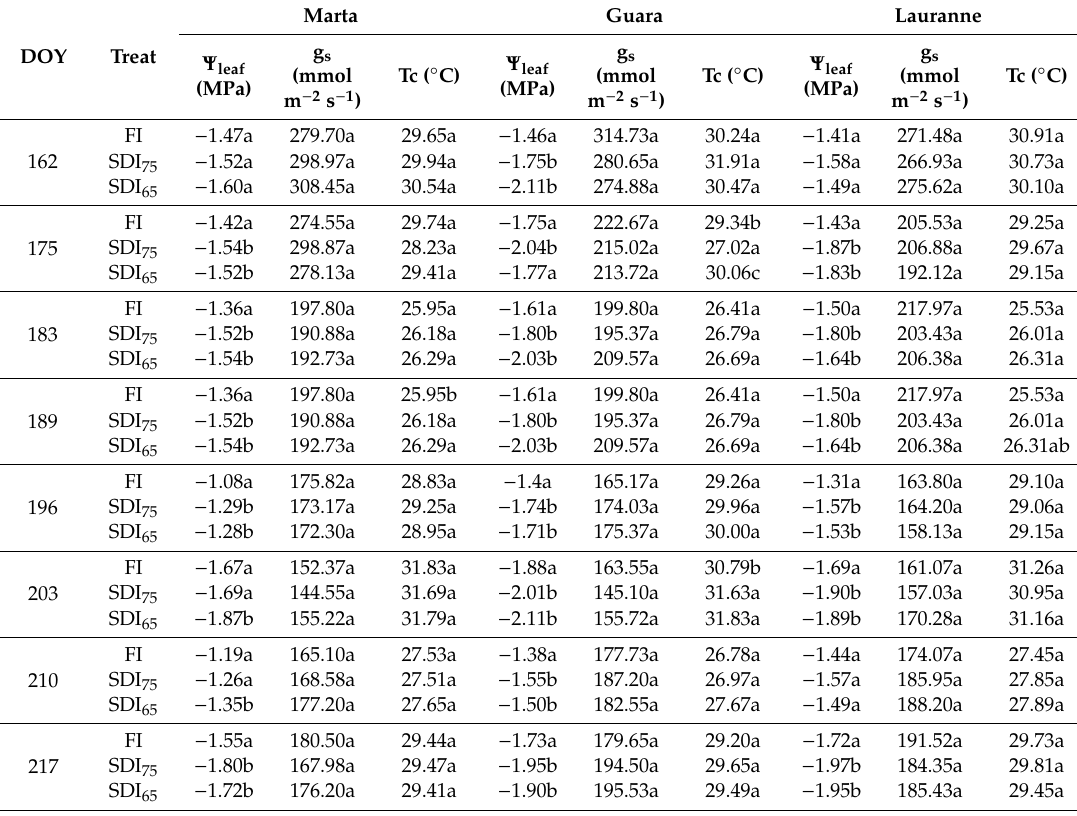
Table 4. Temporal evolution of the physiological variables measured throughout 2019.